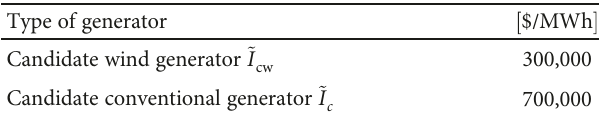
Table 20: Investment costs.